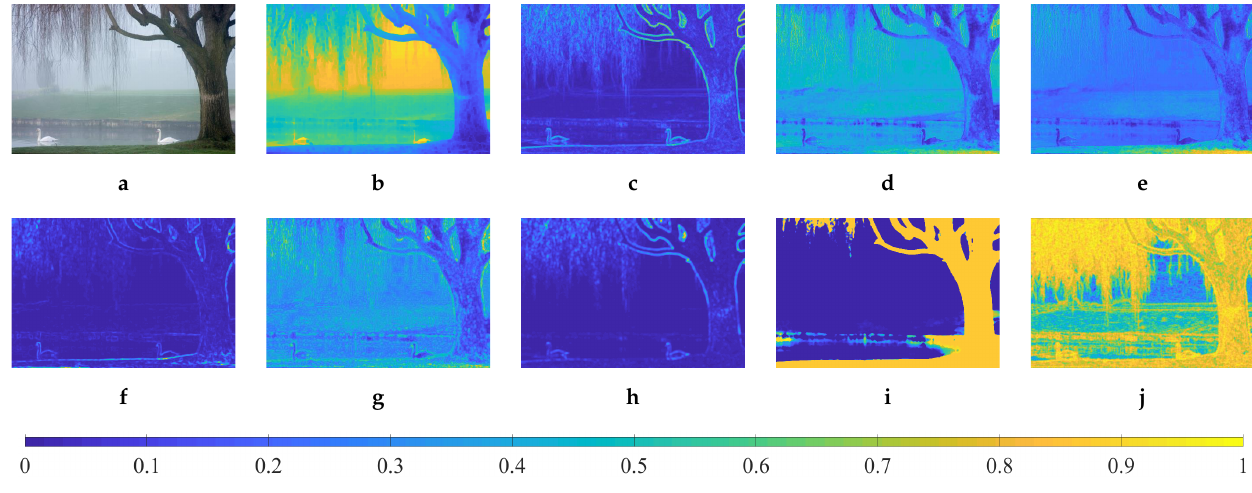
Figure 2. An illustration of a hazy image and its corresponding haze-relevant features. ( a ) Hazy image, and its ( b ) dark channel, ( c ) contrast, ( d ) saturation × value, ( e ) chroma, ( f ) variance of chroma, ( g ) colorfulness, ( h ) sharpness, ( i ) hue disparity, ( j ) image entropy, and ( k ) reference color